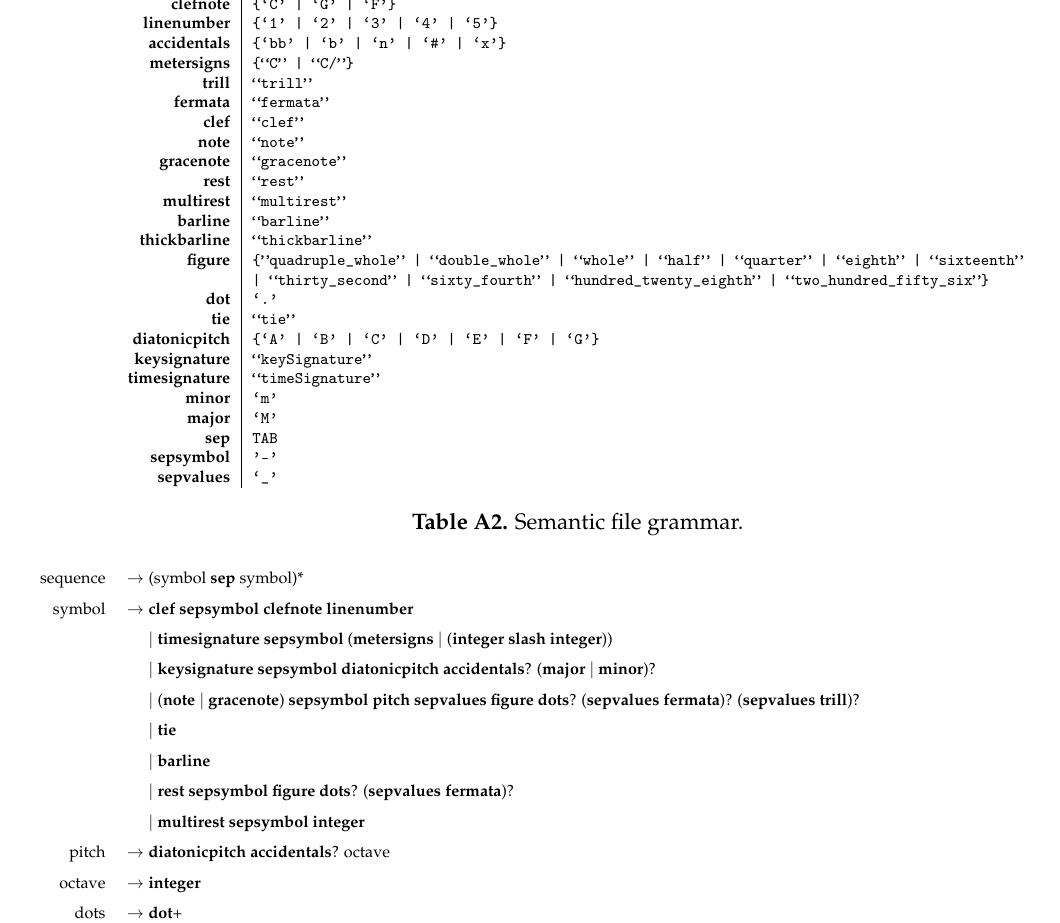
Table A2. Semantic file grammar.